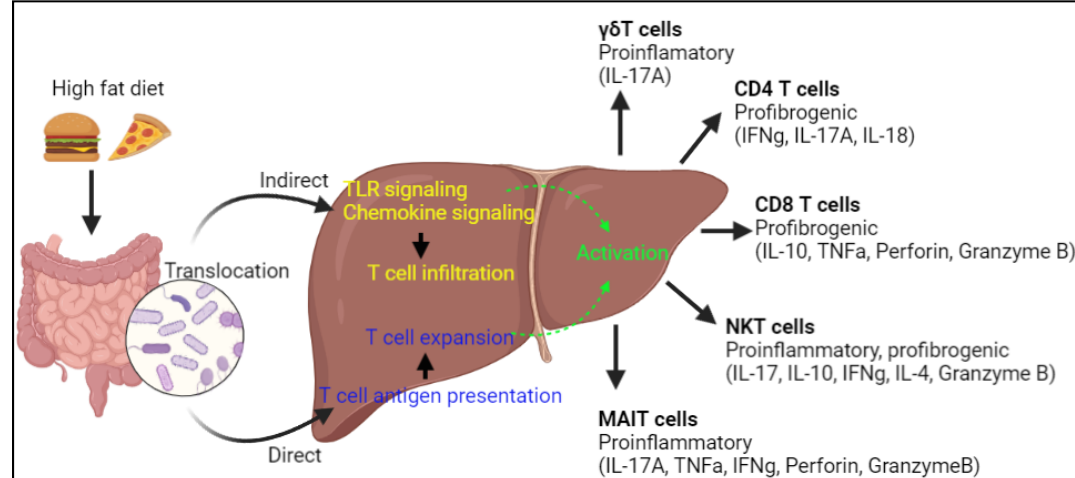
Figure 2. A simplified schematic representation of the gut-liver axis and T cell functions in fatty liver pathogenesis. IL, Interleukin; CD, Cluster of differentiation; TNF, Tumor necrosis factor; IFN, Interferon; NKT, Natural killer T.